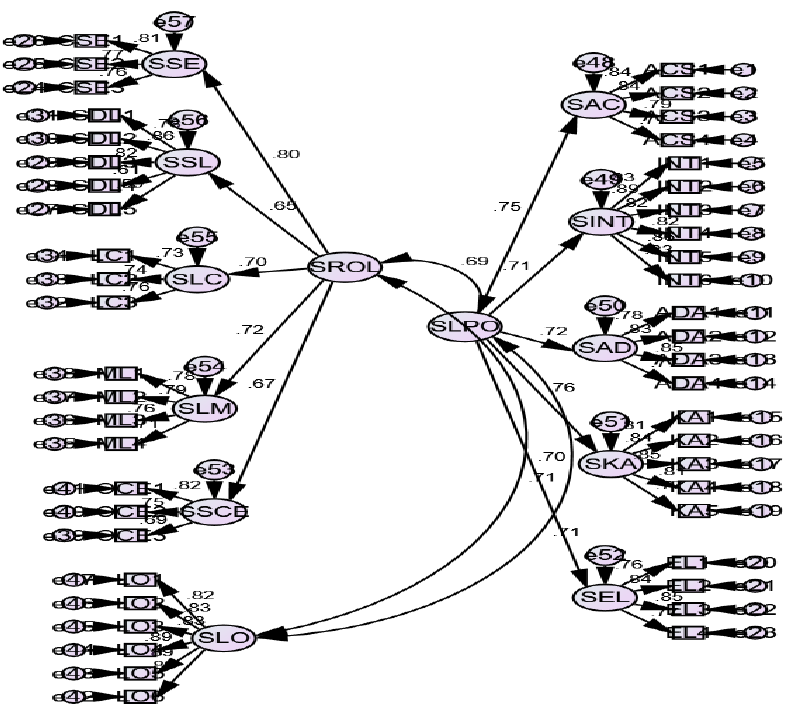
Figure 3. Second-order measurement model for student-level constructs (Level-1: three-factor model).